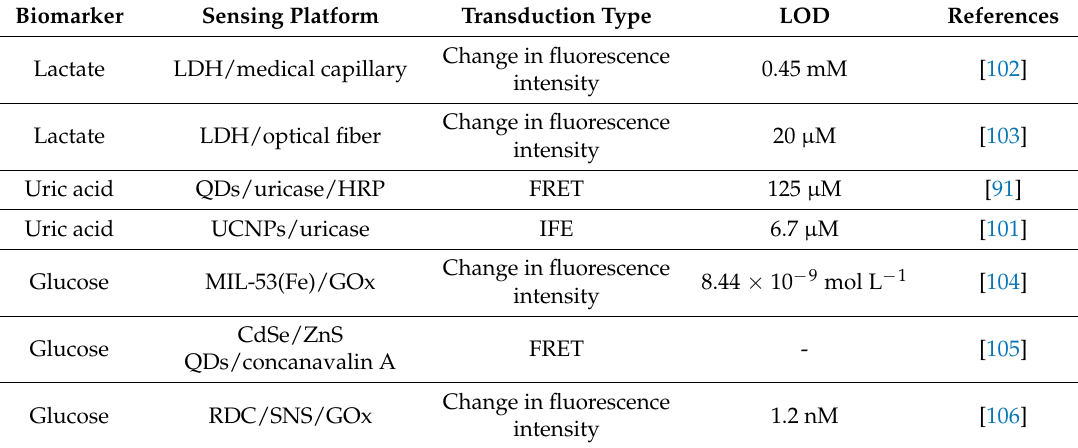
Table 3. Fluorescence-based biosensors for exemplary metabolites